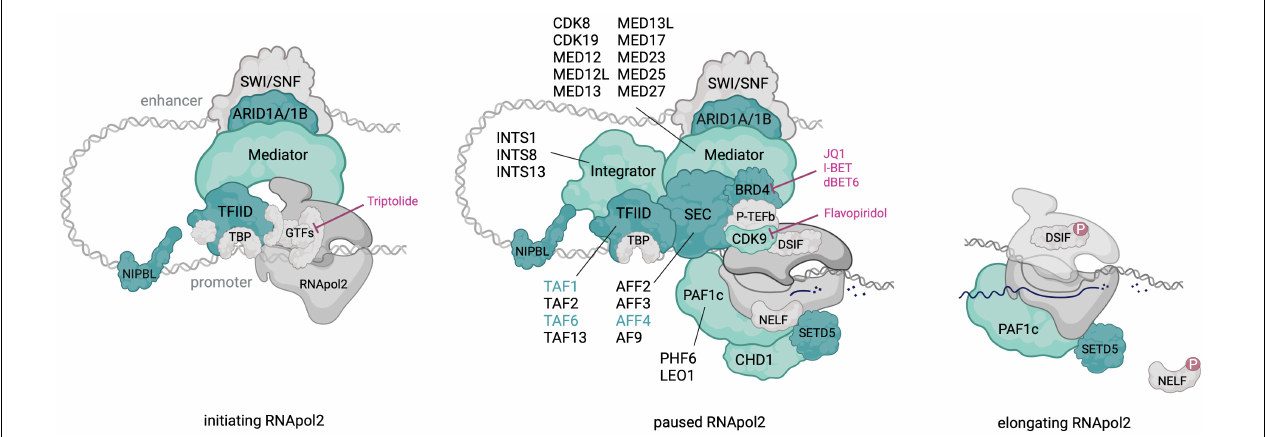
FIGURE 1 | An overview of RNApol2 in initiating, paused and elongating state with transcriptional pausing regulators that contribute to NDDs colored in green. For multi-subunit complexes, subunits with pathogenic NDD variants are outlined. Dark green shading and font highlights factors in which pathogenic variants result in a CdLS-like phenotype. Discussed therapeutics and their targets in the paused RNApol2 complex are indicated. Created with